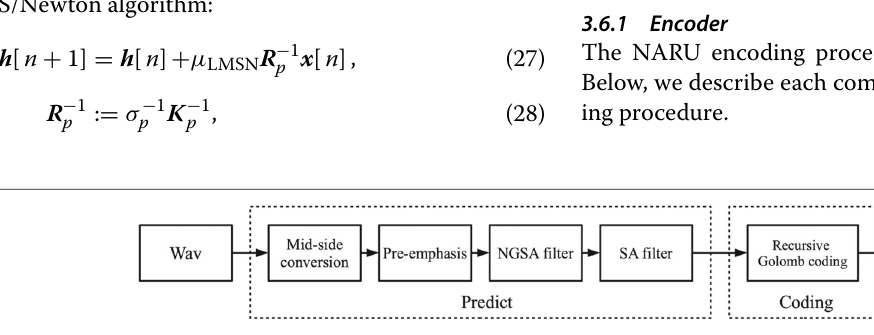
Fig. 4 NARU encoder